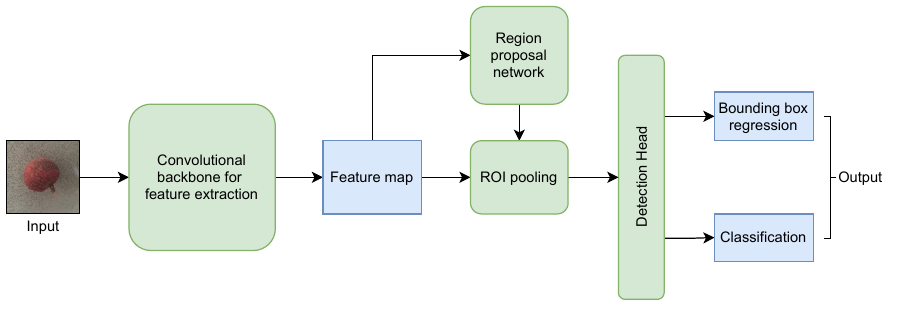
Figure 5. Faster RCNN.